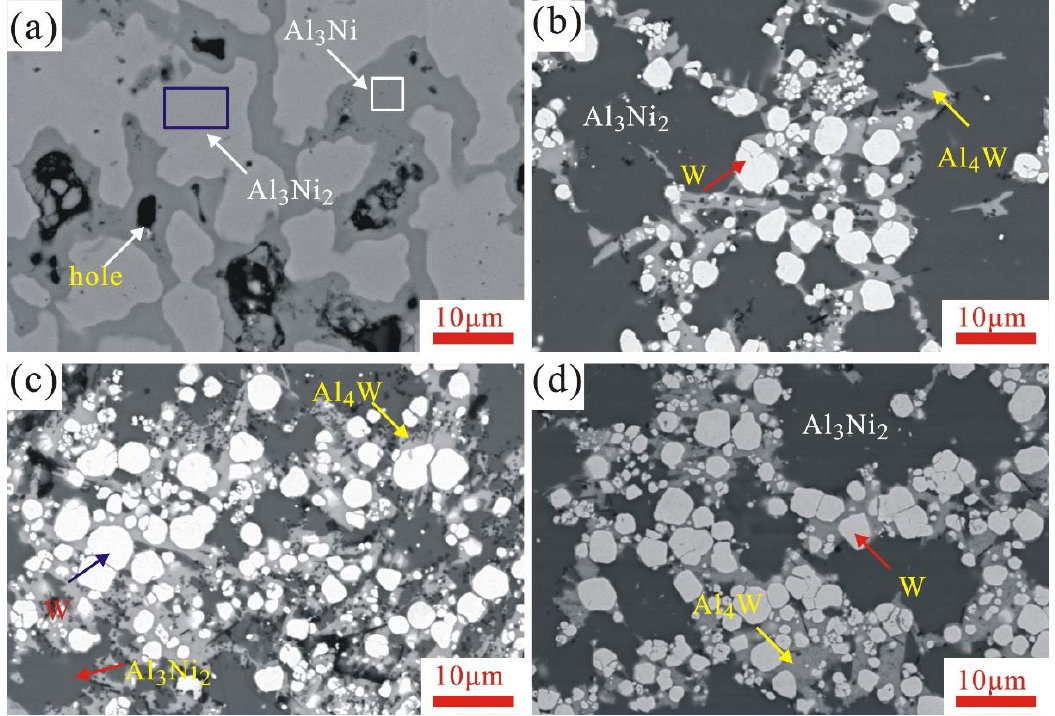
Figure 5. Microstructures of annealed (48Al–52Ni) 100 ‐ x W x composites. ( a ) x = 0; ( b ) x = 25; ( c ) x = 40; ( d ) x = 60.